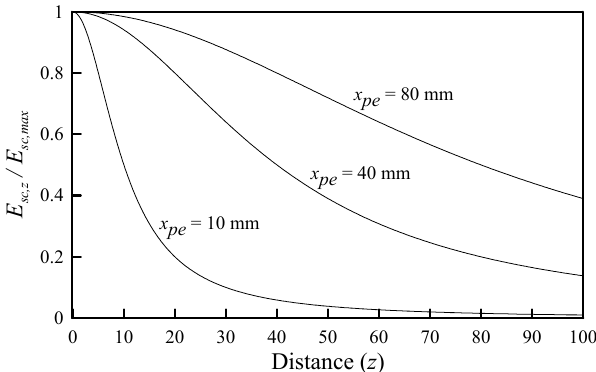
Figure 5. Relation between distance ( z ) and penetration depth ( x pe ).